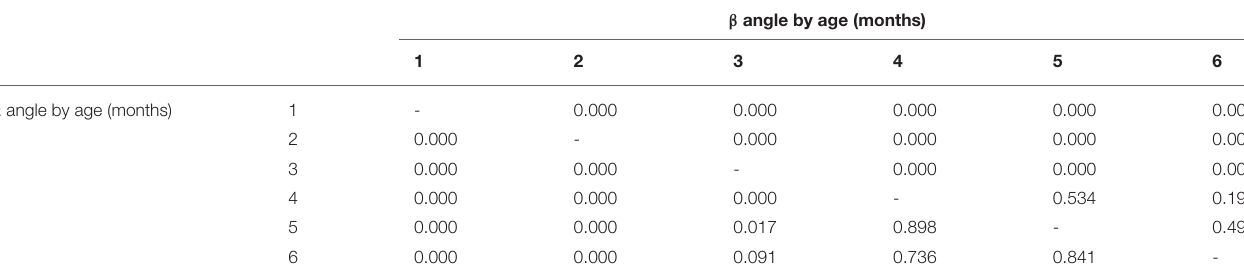
TABLE 4 | Multiple significance comparisons of α angle and β angle over age of months in normal infants.